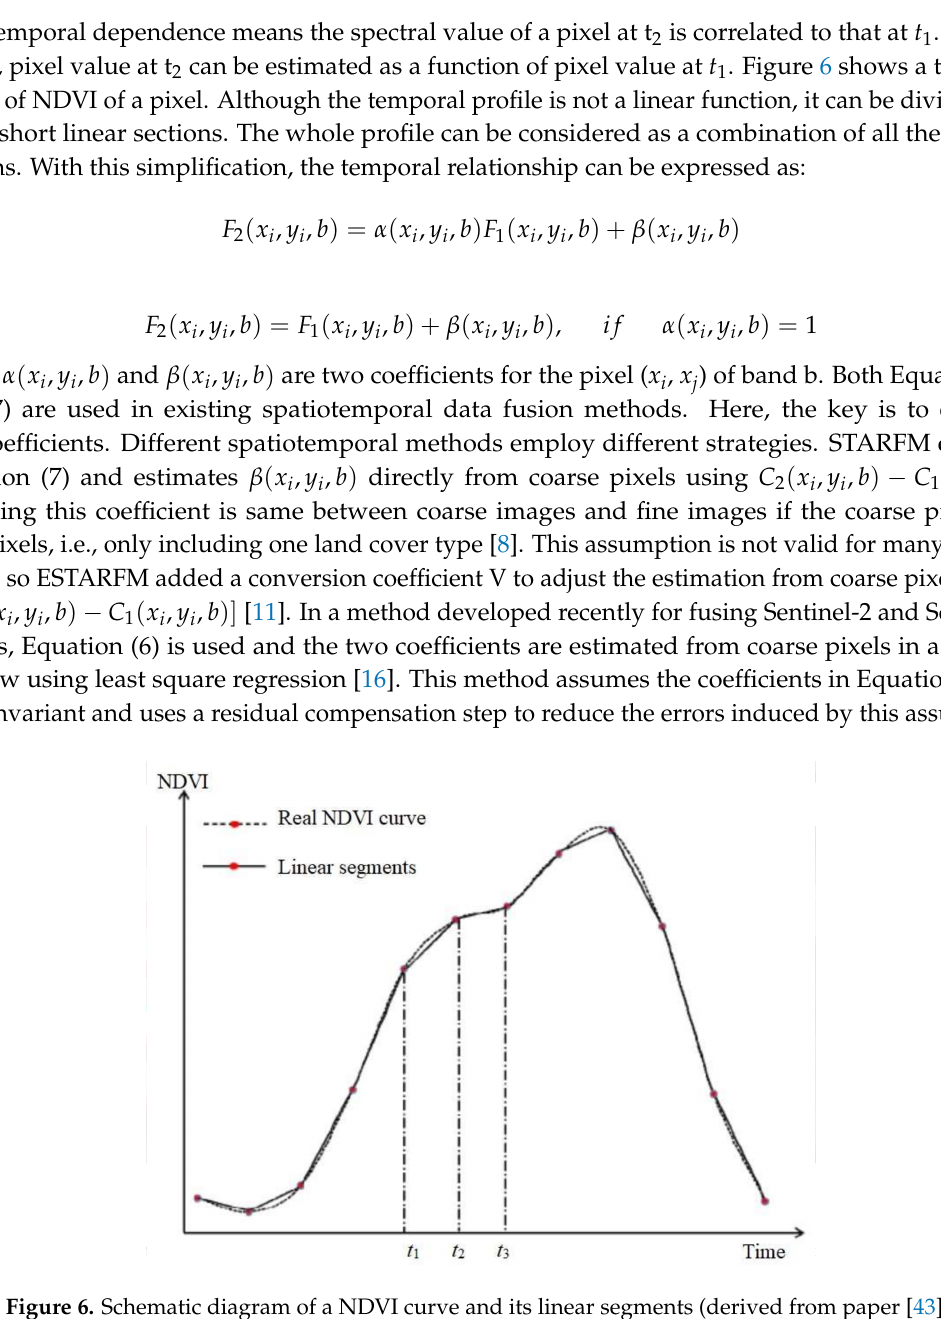
Figure 6. Schematic diagram of a NDVI curve and its linear segments (derived from paper